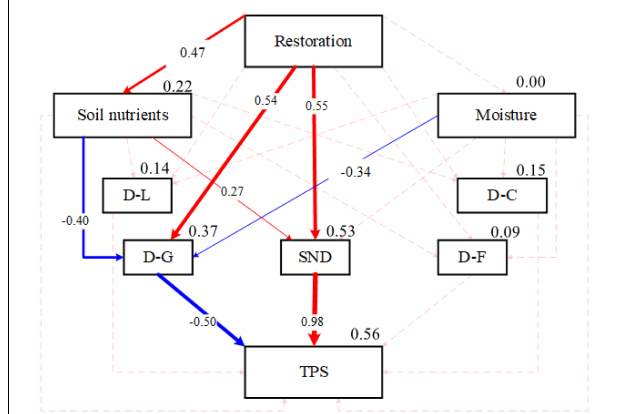
FIGURE 3 | Structural equation model analysis results of community composition, network structure, and community stability path for the recovery years. D-L, D-C, D-G, and D-F, respectively, represent the diversity information of these four plant functional groups (Legume, Cyperaceae, Grass, Forb); TPS, stability of whole community; SND, the complexity of plant interspecific association (network density); Restoration represents human-induced revegetated grassland restoration. The boxes are the variables of the model. The solid line indicates a significant effect ( P < 0.05); the dotted line indicates an insignificant effect ( P > 0.05); Chi_square = 8.40 ( P = 0.40); GF1 = 0.97; RMSEA =